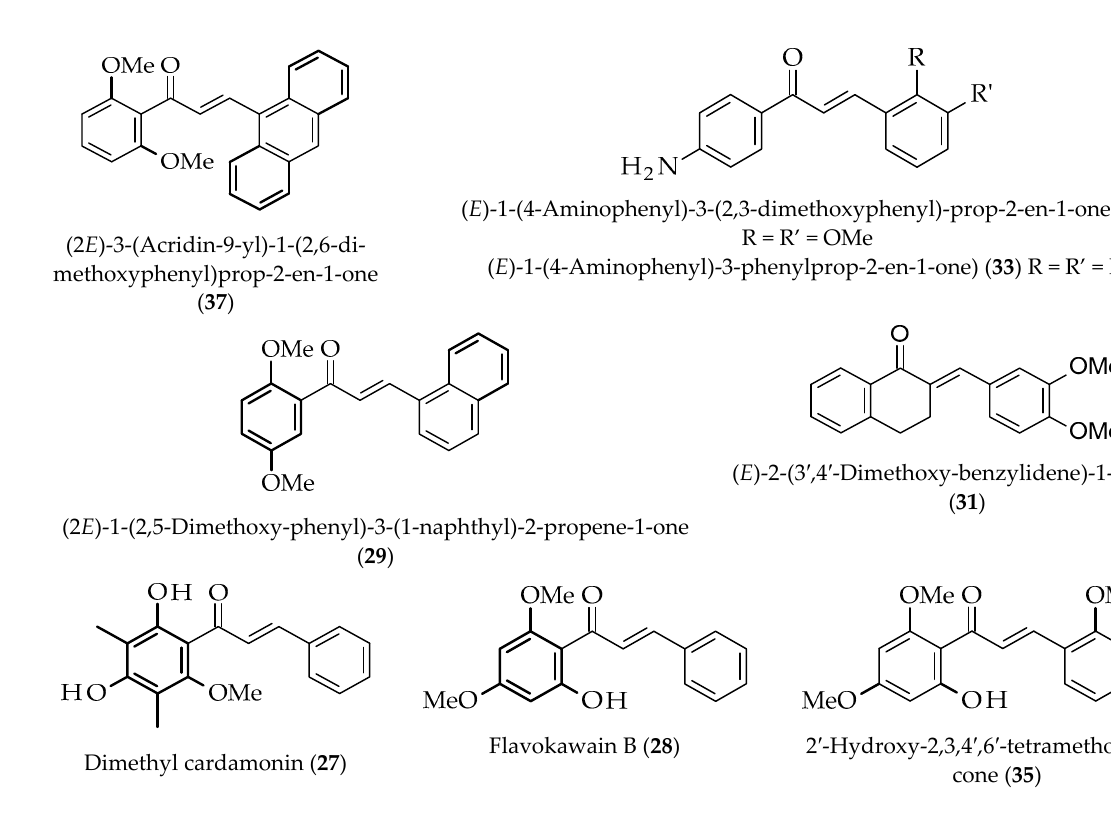
Figure 5. The effect of natural and synthetic chalcones on the cell cycle. Group A: Chalcones arrest the cell cycle at the G 1 /S phase, i.e., dimethyl cardamonin ( 27 ) [30], tetramethoxychalcone ( 34 ) [28], 2 ′ -hydroxy-2,3,4 ′ ,6 ′ -tetramethoxychalcone ( 35 ) [34], and tetrahydro-[1,2,4]triazolo[3,4-a]isoquino- line chalcones ( 36 ) [35]. Group B: Chalcones that arrest the cell cycle at the G 2 /M phase chalcone ( 1 ) [29], isoliquiritigenin ( 22 ) [36], (2 E )-3-(acridin-9-yl)-1-(2,6-dimethoxyphenyl)prop-2-en-1-one ( 37 ) [37], and quinazolinone-chalcone ( 38 ) [38].